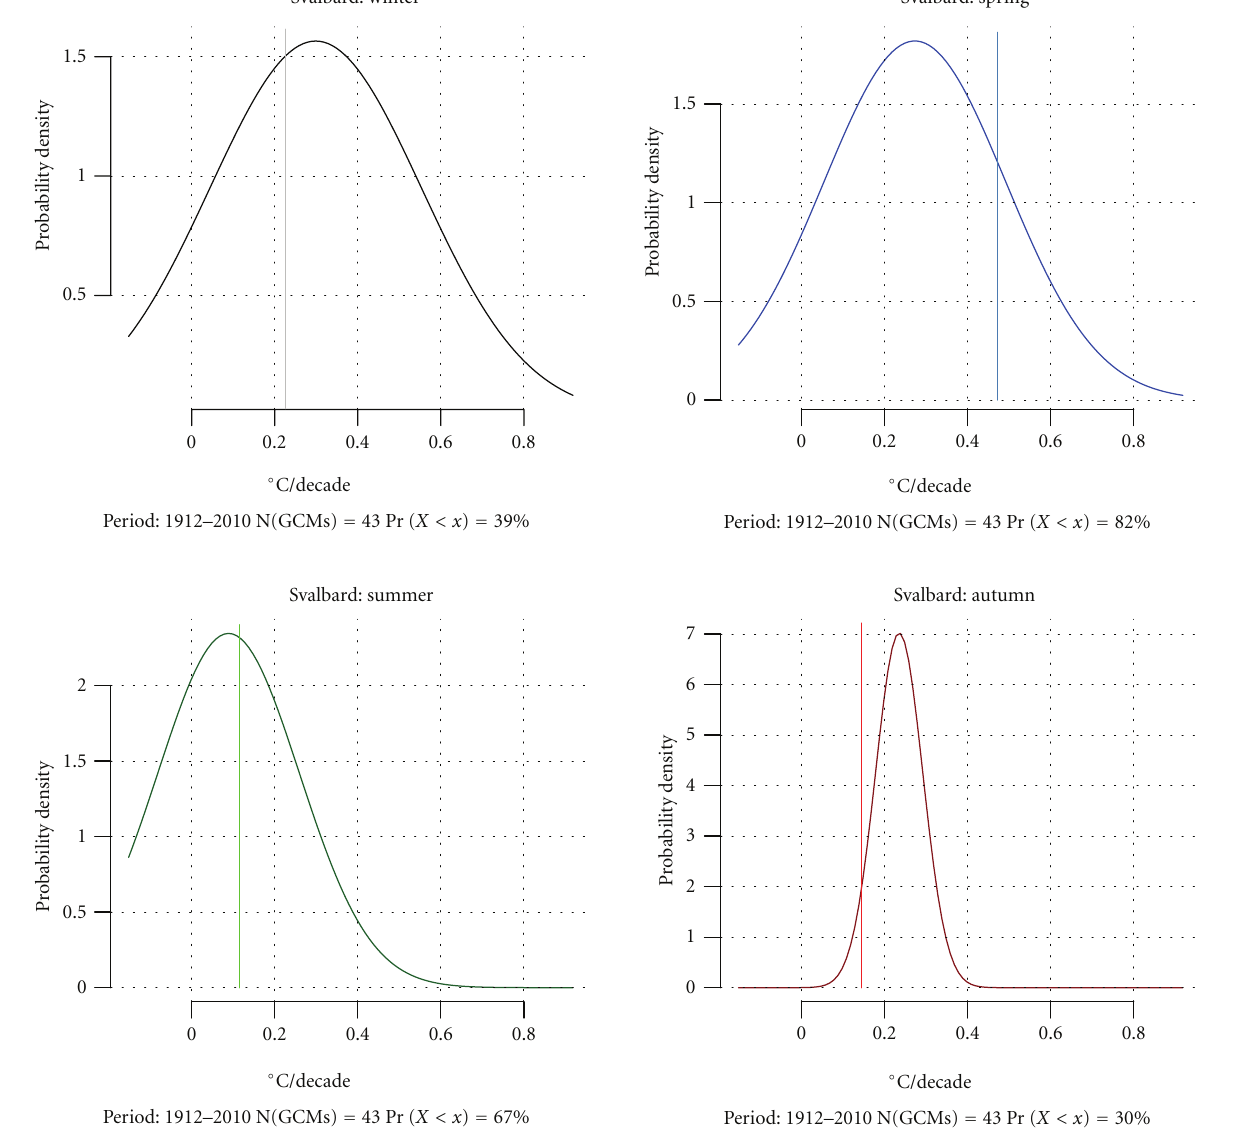
Figure 6: Comparison of downscaled and observed trends for the 1912–2010 period. The curve shows the probability density function of the downscaled results from 43 ESD simulations and the vertical line the observed trend. The probability (Pr) signifies the quantile in the PDF matching the observed